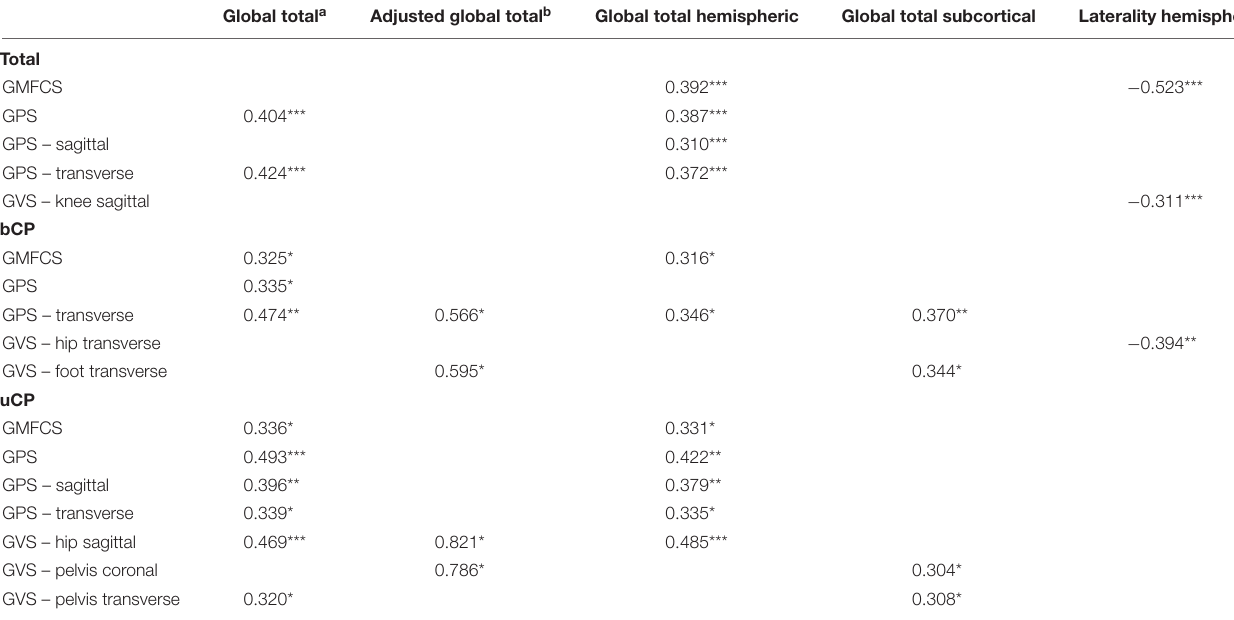
FIGURE 3 | Summary of all statistically significant relationships identified between the dichotomous brain lesion location scores (i.e., subcortical structures and parts of the corpus callosum) and the functional and gait scores (i.e., GMFCS, GPSs, GVSs, and MJ patterns). The total group is depicted with a square, the bCP with a circle and the uCP with a triangle (from left to right: total, bCP, uCP). GMFCS, gross motor function classification system; GPS, gait profile score; GVS, gait variable score; MJ, multiple joint; bCP, bilateral cerebral palsy; uCP, unilateral cerebral palsy. TABLE 1 | Spearman’s rank correlations between the sqMRI extent scores and the scores of functional ability and gait for the total ( N = 104), bilateral ( n = 52), and unilateral ( n = 52)